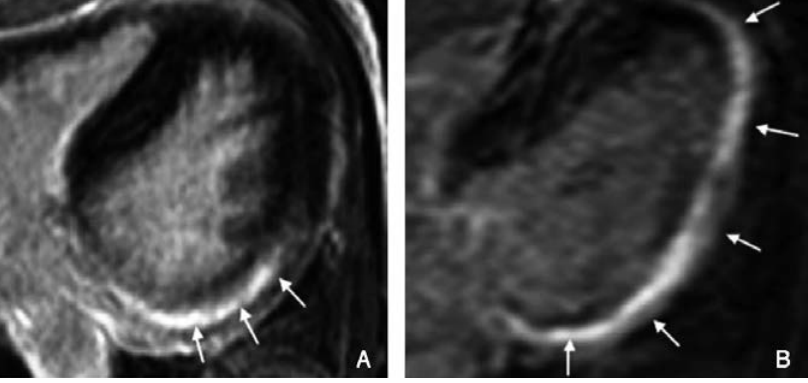
Figure 6. Myocardial fibrosis as a sign of disease progression. Panel A) cardiovascular magnetic resonance image showing an area of myocardial fibrosis involving the postero- lateral wall (arrows in four-chamber horizontal long-axis view). Panel B) the extension of fibrosis is significantly increased, despite 6 years of enzyme replacement therapy ( Reprinted with permission of the publisher from Imbriaco et al. 101 ).